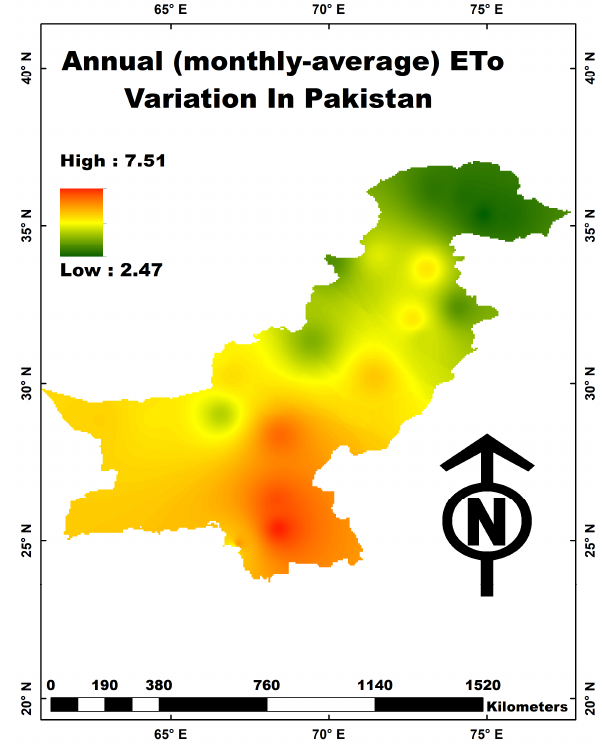
Figure 12. Annual ET o map of Pakistan based on geographic data.